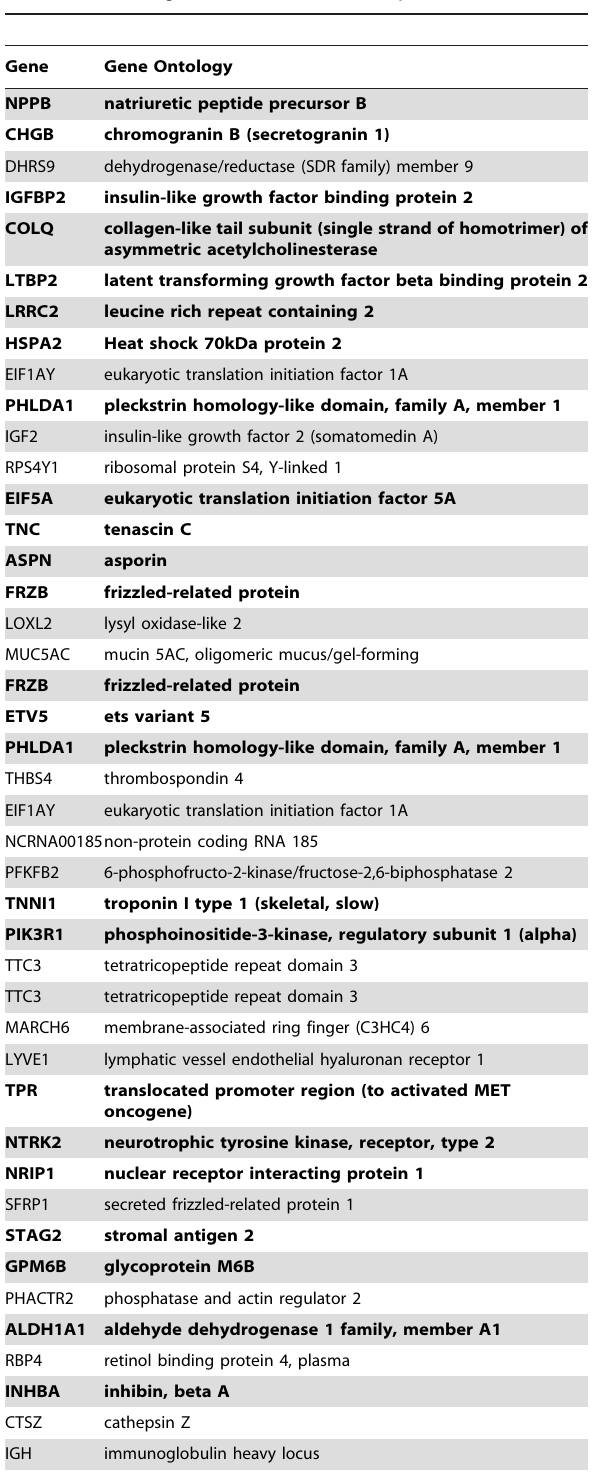
Table 7. Genes with the highest scores (in absolute value) for the factor loadings of the 2 nd PCs for chip U133A (FL2A).